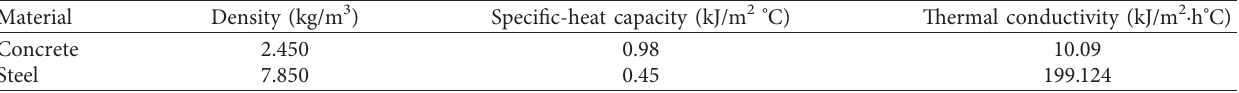
Figure 5: Change in hydration temperature in the CFST members over time when curing at 0 ° C. (a) 1.4-m diameter. (b) 1.6-m diameter. (c) Maximum temperature difference. Table 2: Thermal parameters of the materials used in the finite element